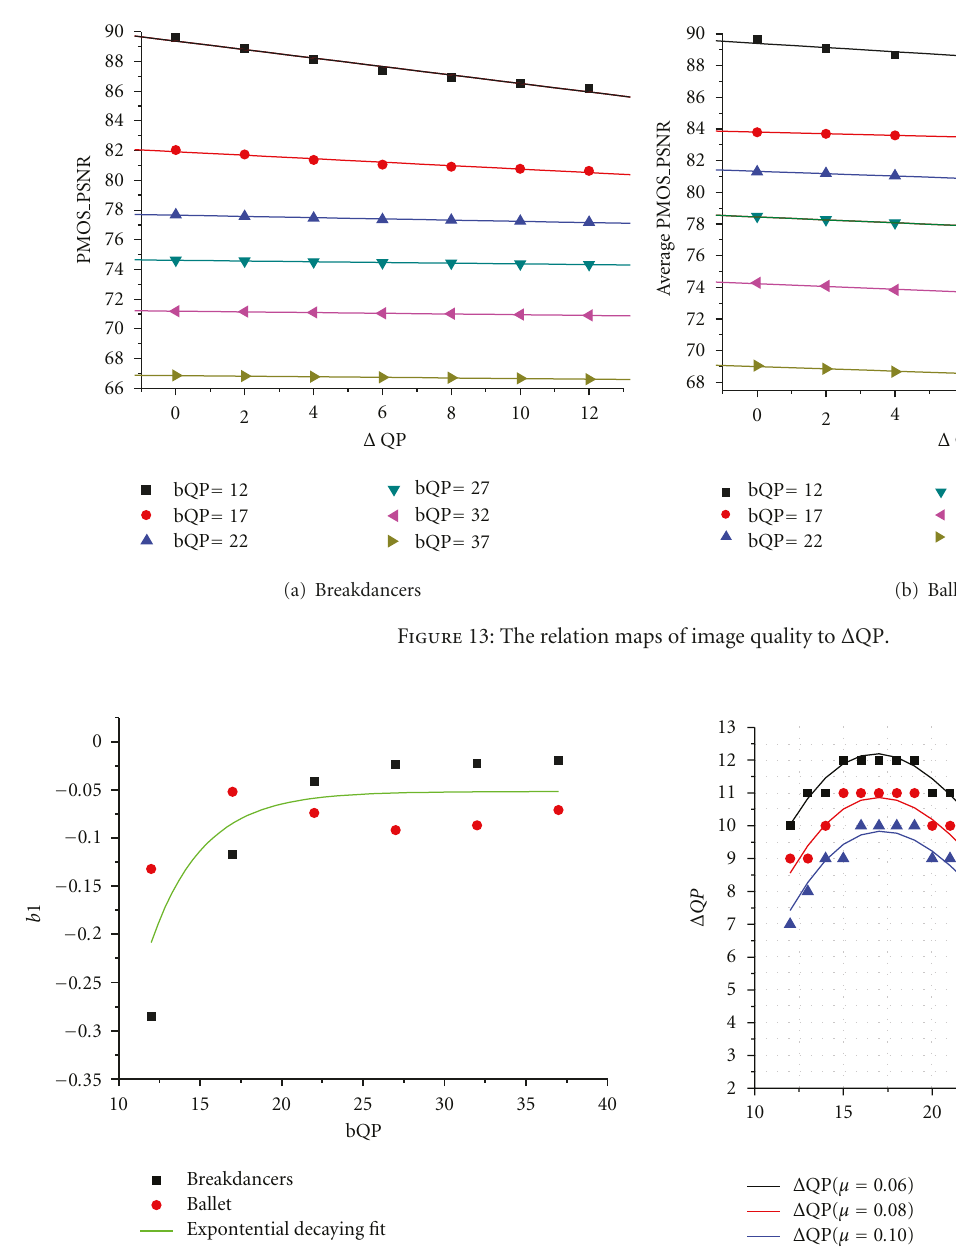
Figure 14: Relation map of bQP and b 1 .